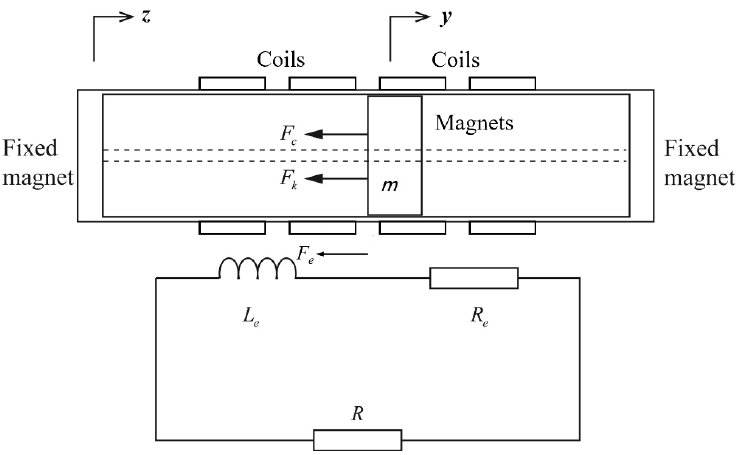
Figure 1. A Single-Degree-Of-Freedom (SDOF) nonlinear cylindrical tube generator.